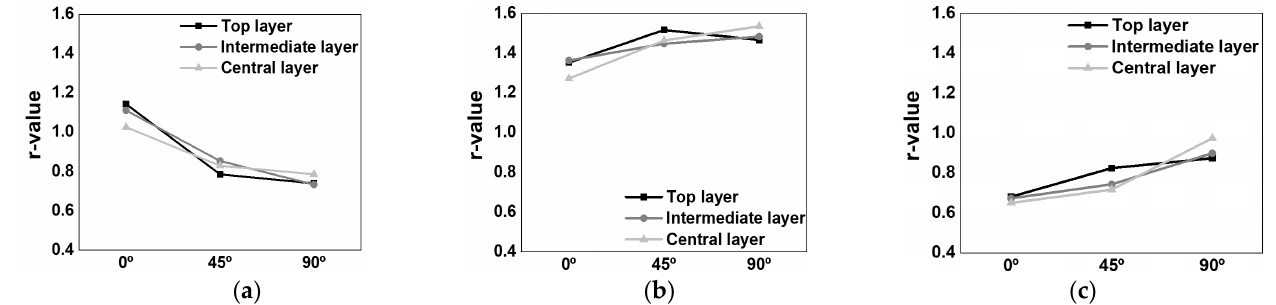
Figure 5. Distributions of r-values calculated from each layer: ( a ) Compression on X-plane, ( b ) Compression on Y-plane, ( c ) Compression on Z-plane.